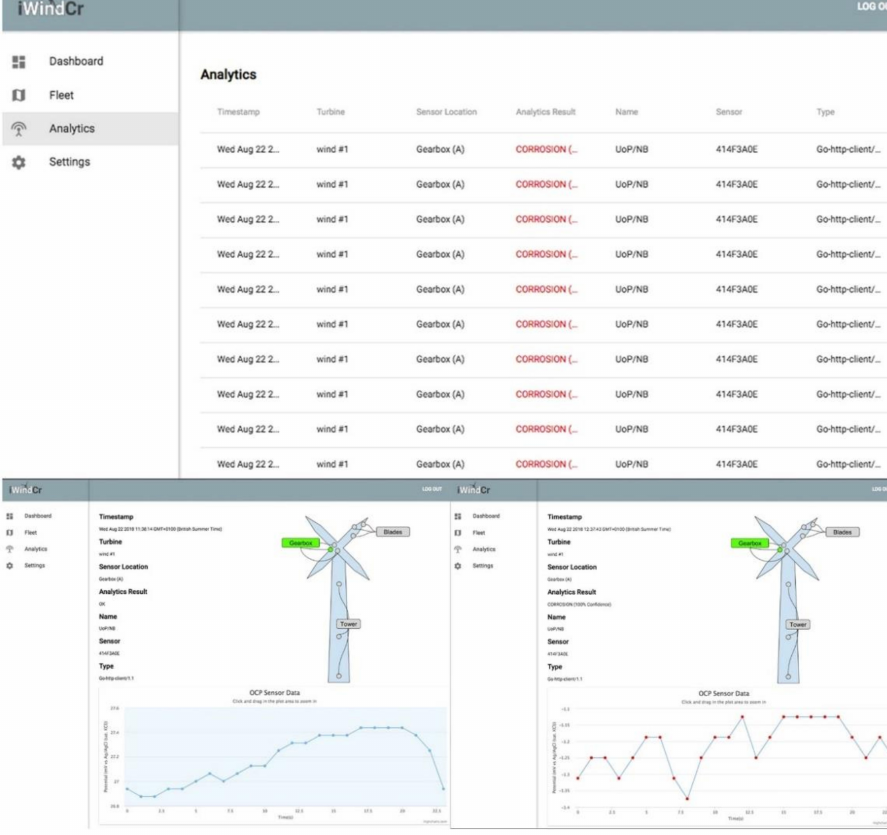
Figure 26. The user interface of iWindCr software